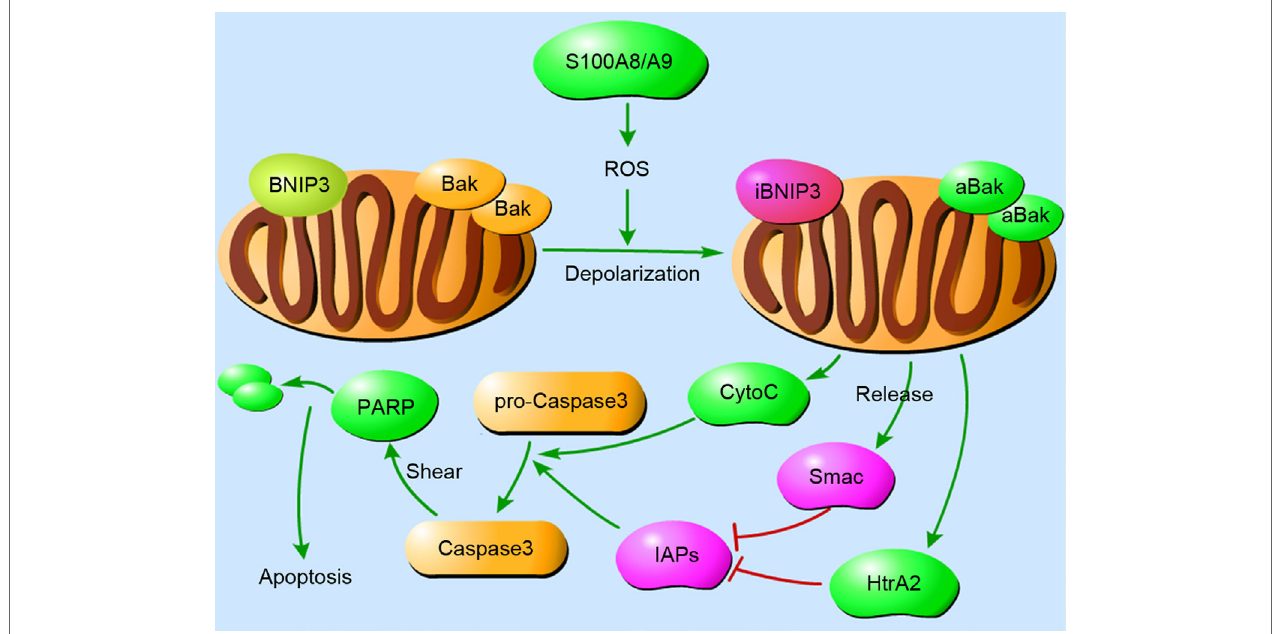
FiGURe 2 | The mitochondrial pathways of S100A8/A9-induced apoptosis. Cellular apoptosis is a cascade that involves a rapid drop in mitochondrial membrane potential. S100A8/A9 increases reactive oxygen species (ROS) production, resulting in the depolarization of mitochondrial membranes and subsequent inhibition of BNIP3, an atypical pro-apoptotic Bcl2-family member, and activation of Bak. After the translocation of Bak and BNIP3 in mitochondria, cytochrome C, Smac, and HtrA2 are concomitantly released from mitochondria into the cytoplasm. They activate caspase-3 in a direct way or in an IAPs-dependent manner to induce apoptosis. Abbreviations: iBNIP3, inhibited BNIP3; aBak, activated